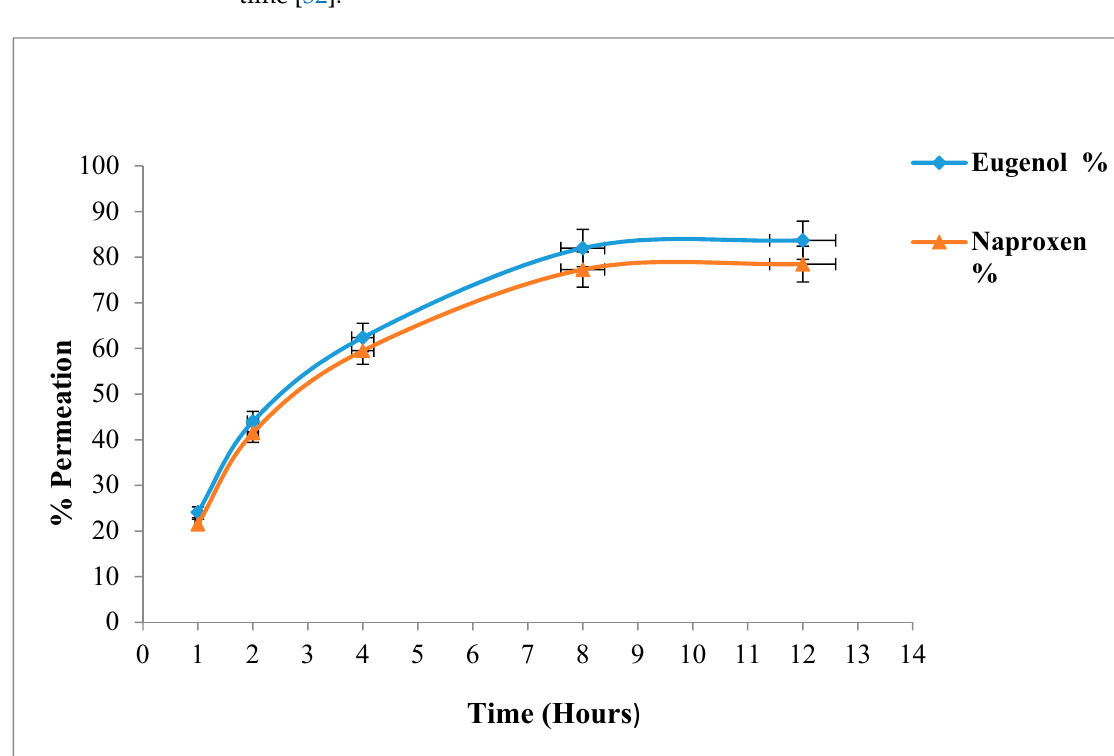
Figure 2. Cumulative permeation of naproxen and eugenol from optimized emulgel.